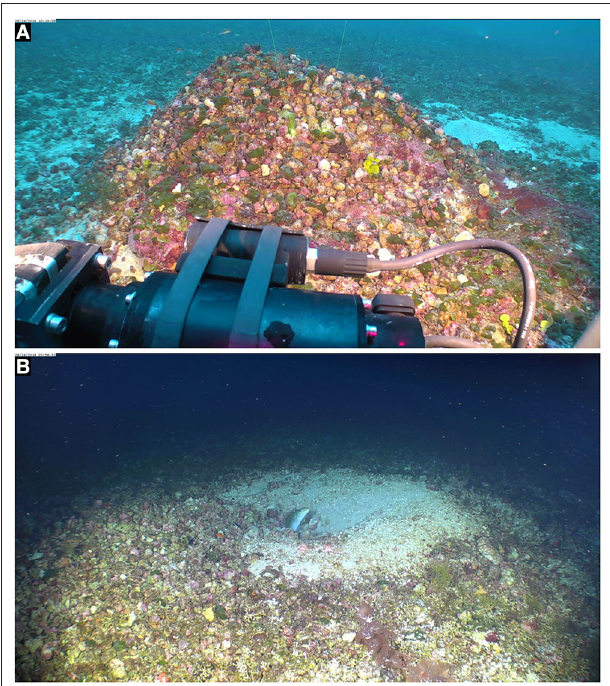
FIGURE 3 | Mound of rhodoliths with attached fleshy and crustose red, brown, and green seaweeds, built by sand tilefish ( Malacanthus plumieri Bloch 1786, Malacanthidae). Mohawk ROV photos taken on 24 Sept. 2018 in East Flower Garden Bank (FGBNMS). (A) (27 ◦ 55’22.1334“N, 93 ◦ 35’31.8048”W, 51.2m (Dive 702_0063_131400). (B) Sand tilefish at entry of its rhodolith mound, 27 ◦ 56’20.7132“N, 93 ◦ 36’1.1052”W, 51.8m (Dive 700_0040_075832). Space between spot lasers =